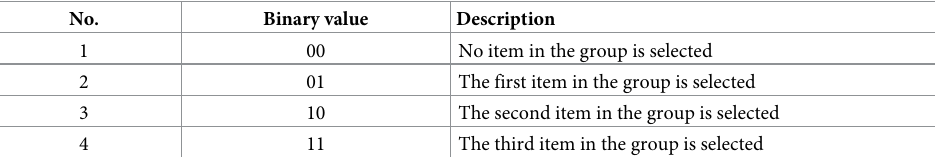
Table 1. Binary encoding